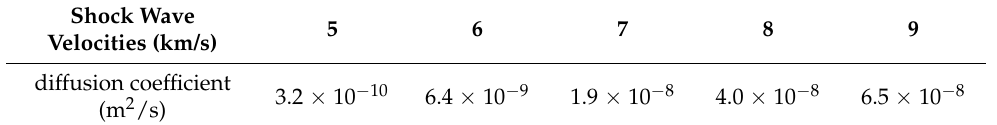
Figure 7. Mean squared displacement (MSD) for ( a ) the voids-free system and ( b ) the nanovoid- containing system, at different shock wave velocities.